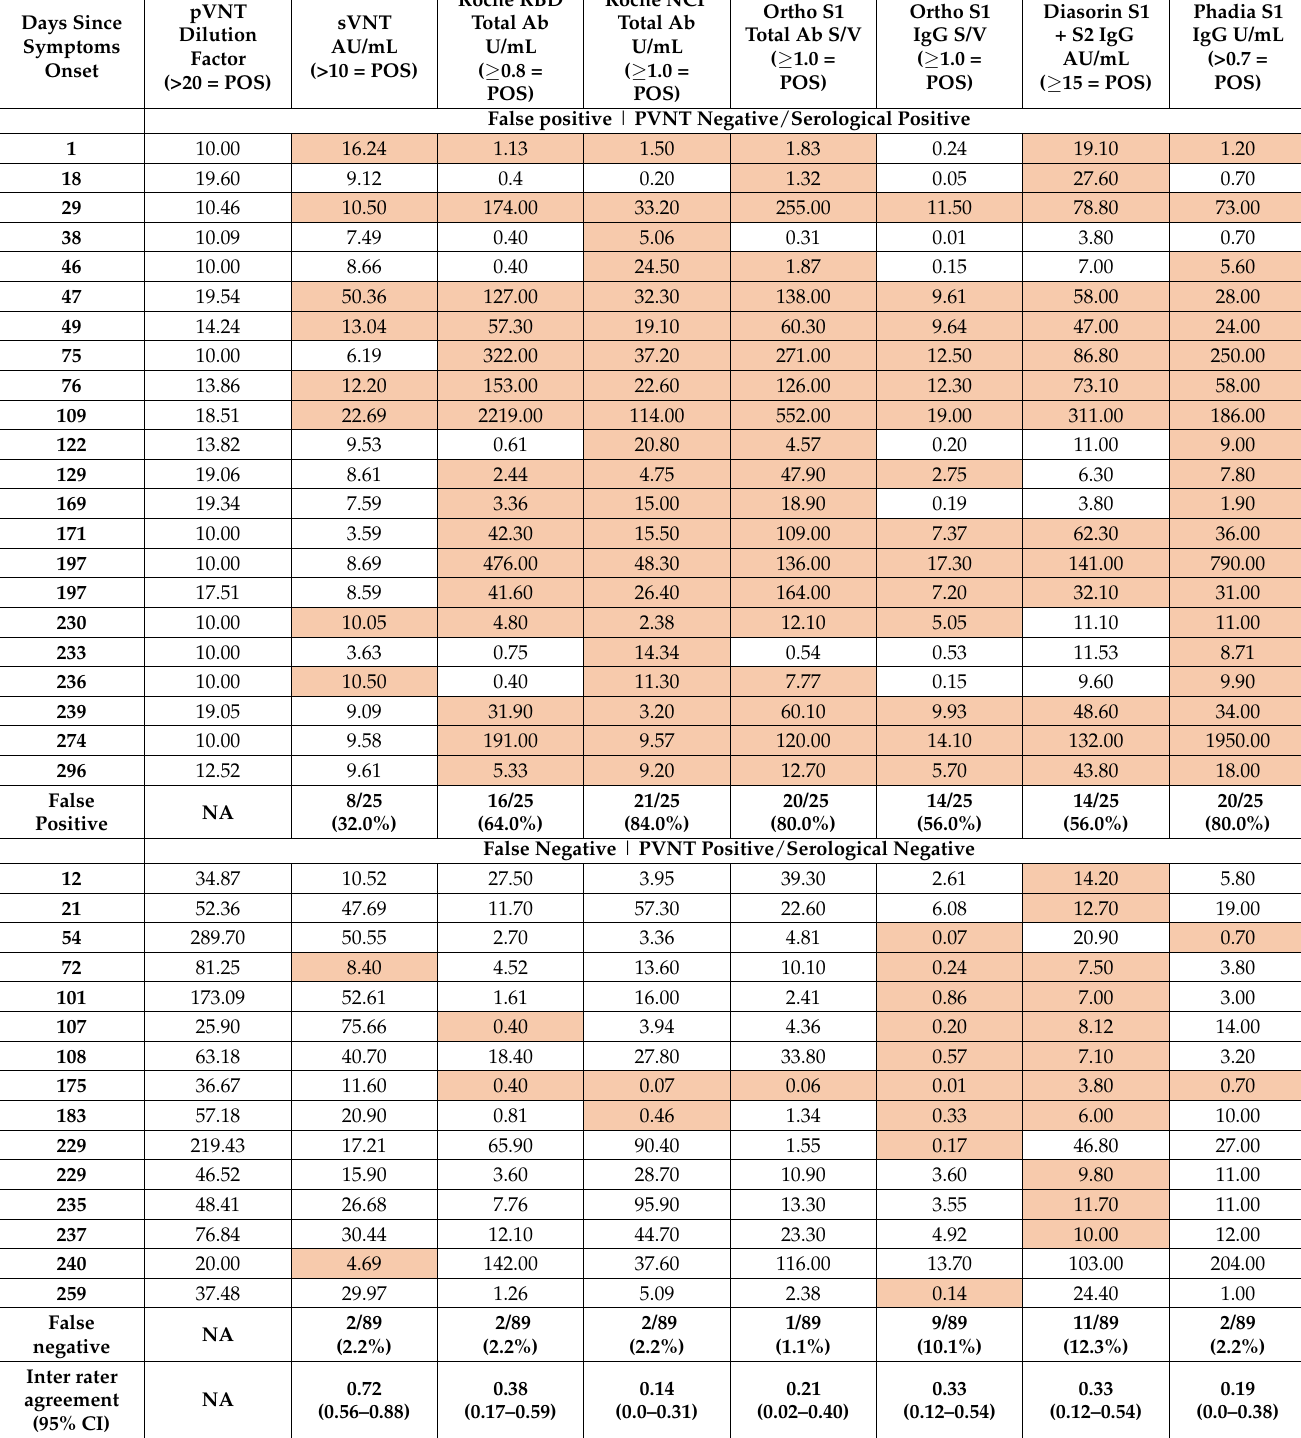
Table 2. Summary of discrepancies between pVNT versus serological assays and sVNT in samples from patients with COVID-19. The total number of pVNT negative and positive samples were 25 and 89, respectively. Discordant results between pVNT and serological tests are highlighted in